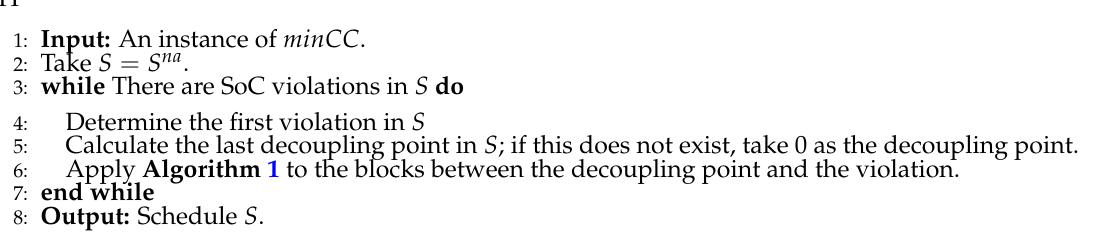
Algorithm 2 Minimizing charging cycles for a single